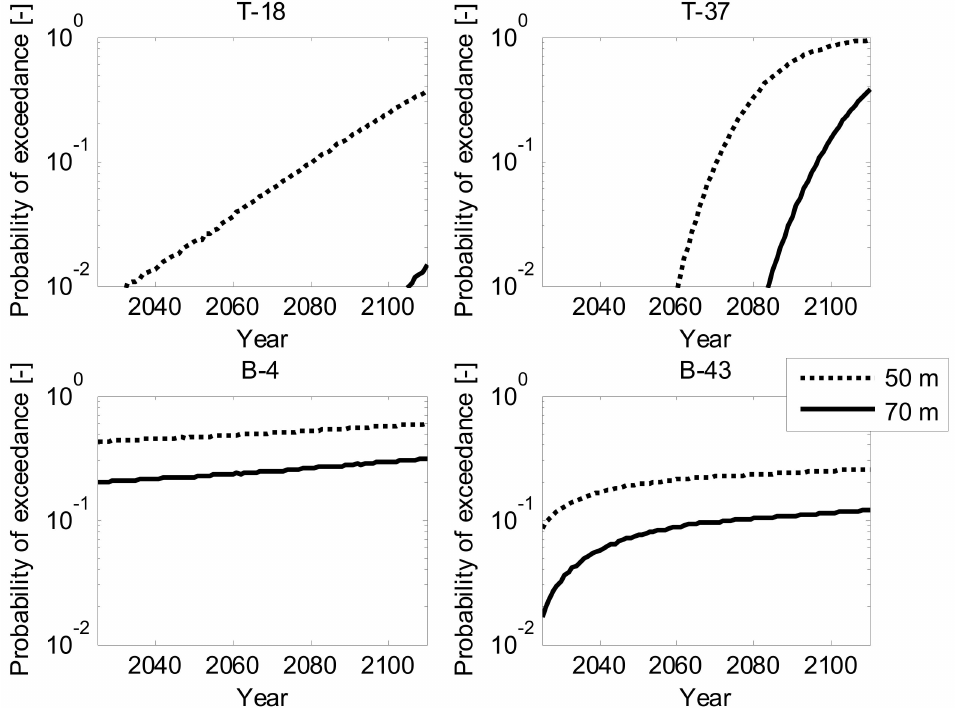
Figure 17. Increase in the annual probability of coastal recession reaching fixed location at 50 or 70 m distances from the